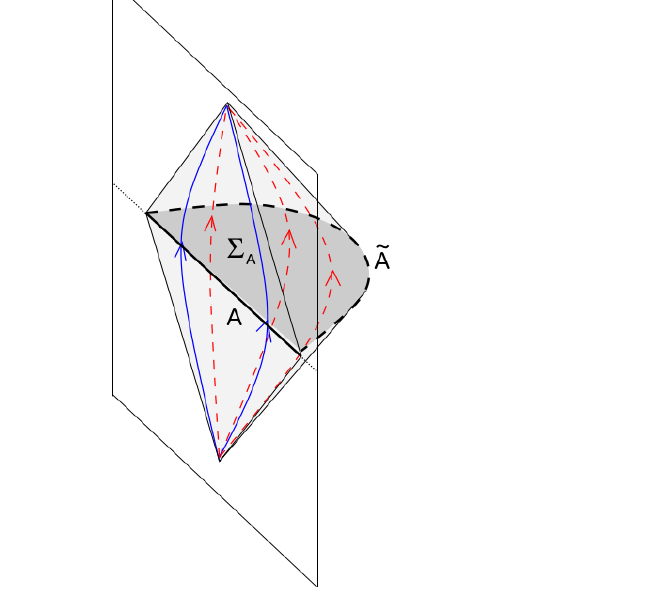
Figure 1 . AdS-Rindler patch associated with a ball A on a spatial slice of the boundary. Solid blue paths indicate the boundary (cid:13)ow associated with H A and the conformal Killing vector (cid:16) A . Dashed red paths indicate the action of the Killing vector (cid:24) A